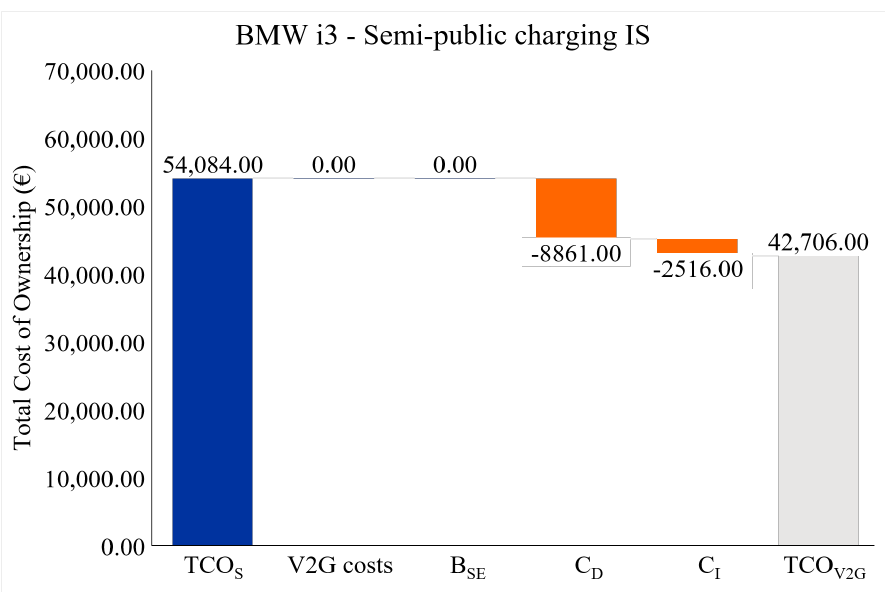
Figure A16. Standard and V2G TCO of a BMW i3 in a semi-public charging case providing IS ( TCO S = Standard TCO, B SE = benefit of saved electricity costs from the grid, C D = direct compensa- tion, C I = indirect compensation, TCO V 2 G = V2G TCO); source: own compilation).